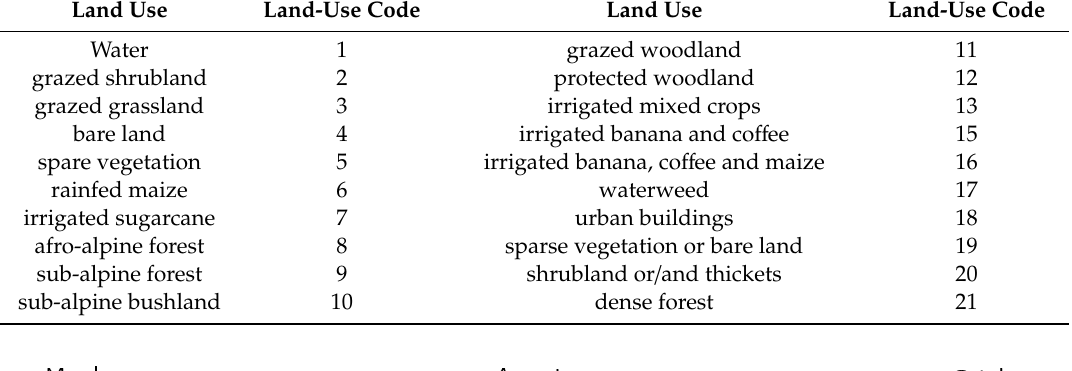
Table 1. Land use and the corresponding trajectory codes.